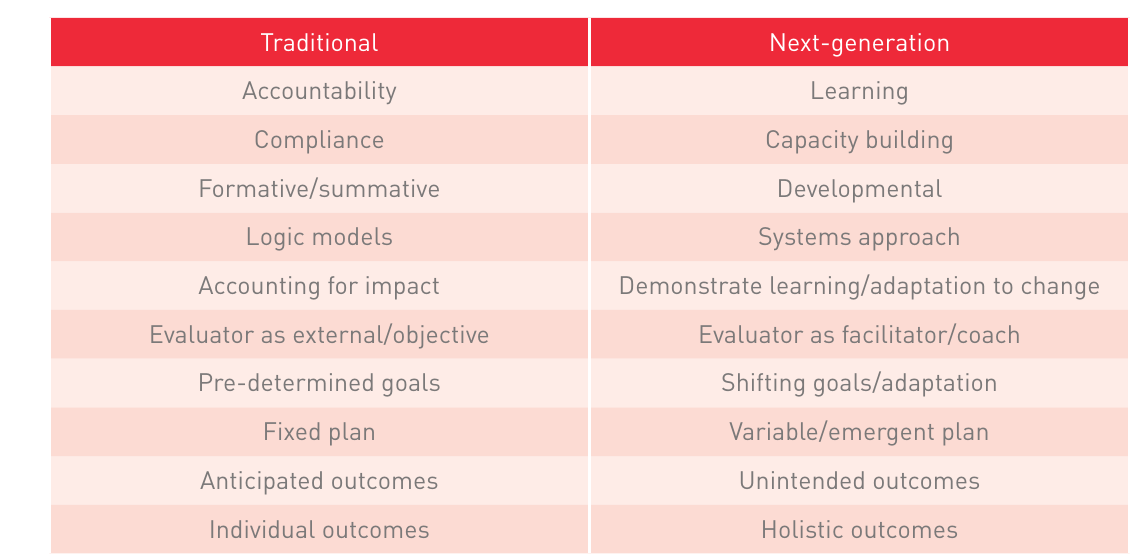
Key features and focus of traditional and next- generation